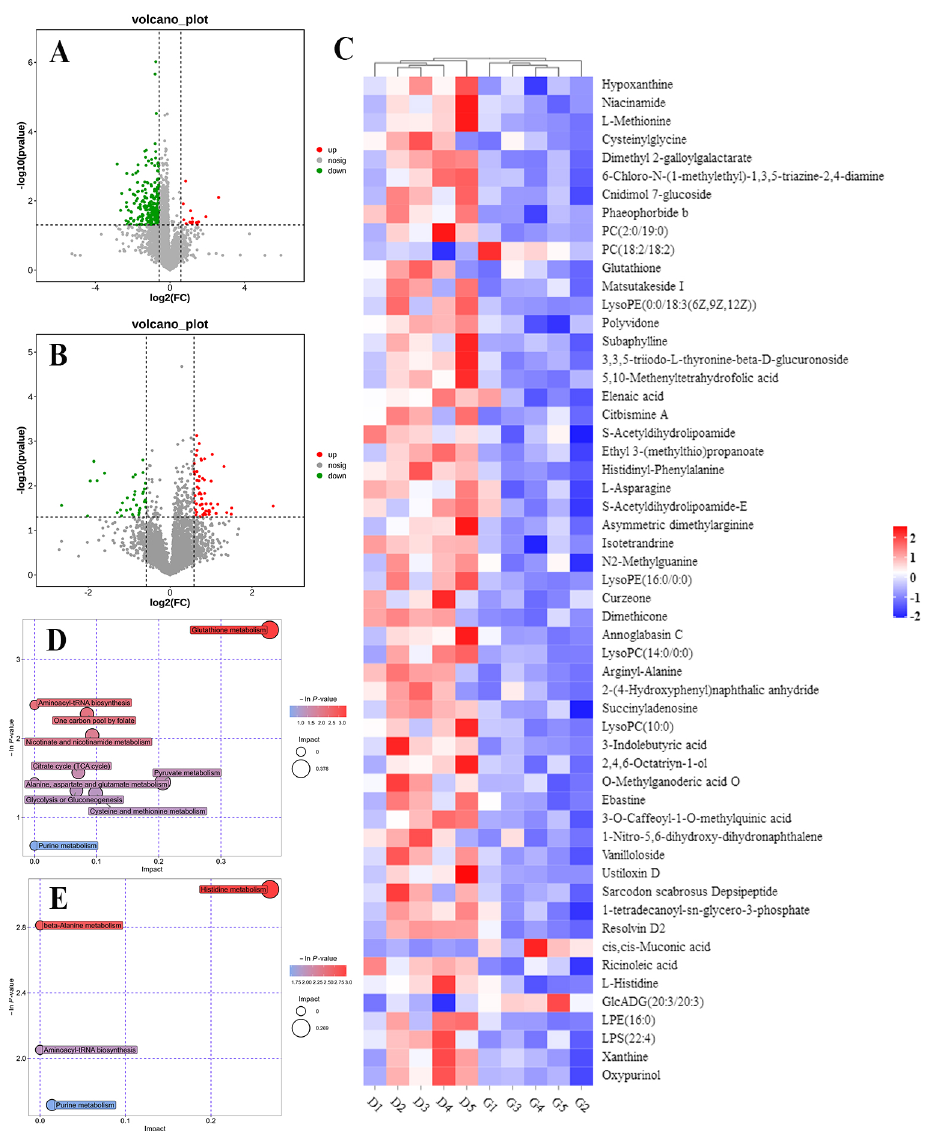
Figure 6. The effect of the green light stimulation during incubation on global metabolomics profiles in the liver. POS, positive ion mode; NEG, negative ion mode. ( A , B ) Volcano plot showing the